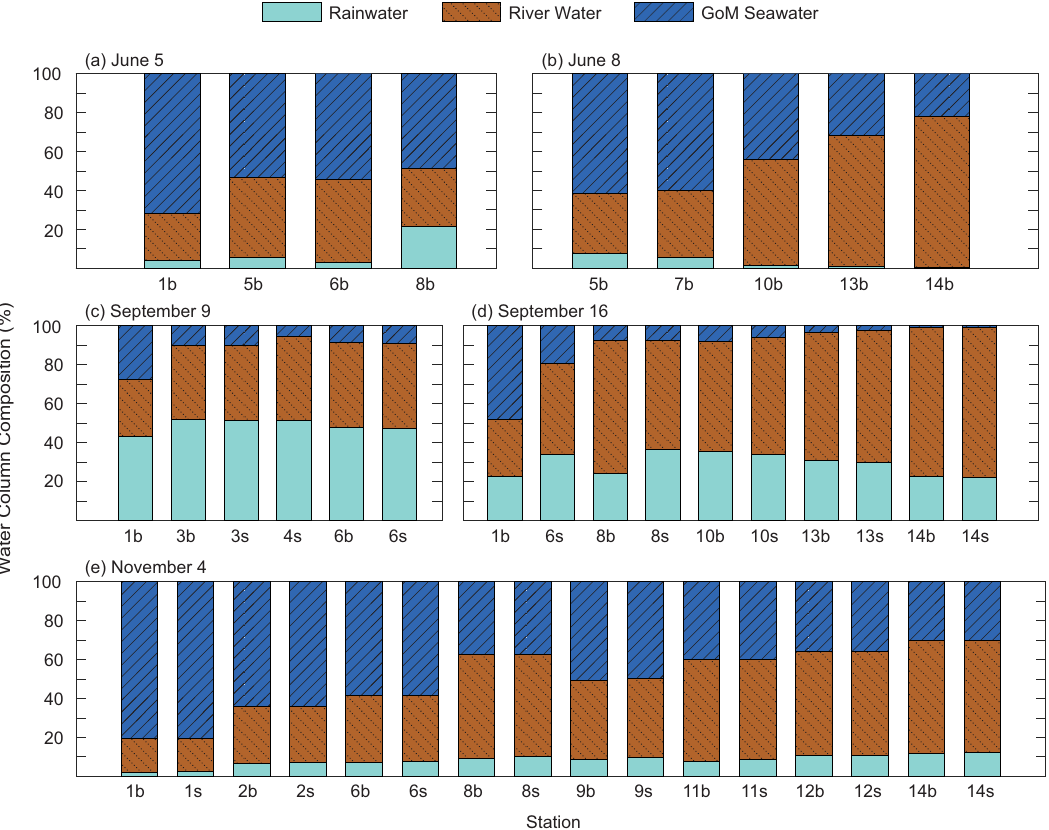
Fig. 4 Percent of the Galveston Bay water column composed of rainwater, Galveston-watershed river water, and Gulf of Mexico seawater. Stacked bar charts indicate water column composition for 2017 sampling in a , b June, c , d September, and e November. The “ b ” indicates bottom sample (~1.2m from bottom) and “ s ” indicates surface sample (~0.5 m) data. Teal is rainwater, brown with backslashes is Galveston-watershed river water, and dark blue with forward slashes is Gulf of Mexico seawater. Note that Galveston Bay water composition is summarized for 2018 sampling dates in Supplementary Fig.